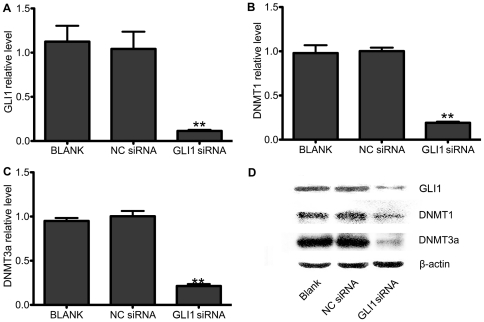
DNMT1 and DNMT3a were suppressed after transfected by GLI1-siRNA in PANC-1 cells.PANC-1 cells were transfected with GLI1 siRNA, 72 hours after transfection, relative expression of GLI1, DNMT1 and DNMT3a mRNA was assessed by qRT-PCR (A, B, C), while the expression of GLI1, DNMT1 and DNMT3a protein was analyzed by Western blot (D). The inset shows a substantial decrease in DNMT1 and DNMT3a expression after GLI1 interference. The results were normalized to that of β-actin expression. All data were presented as the mean ± SD of three independent experiments.